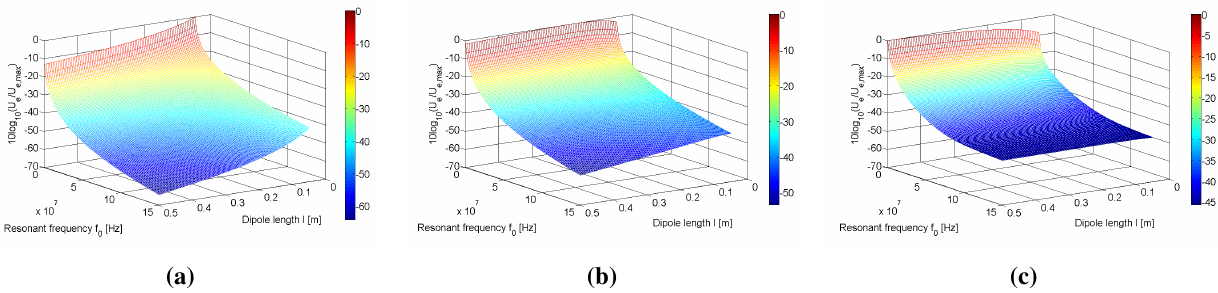
Figure 6. Variation of the figure of merit U frequency f and dipole length l for (a) d = 0 . 01 m, (b) d = 0 . 1 m and (c) d = 0 . 5 m for the 0 coaxial configuration.